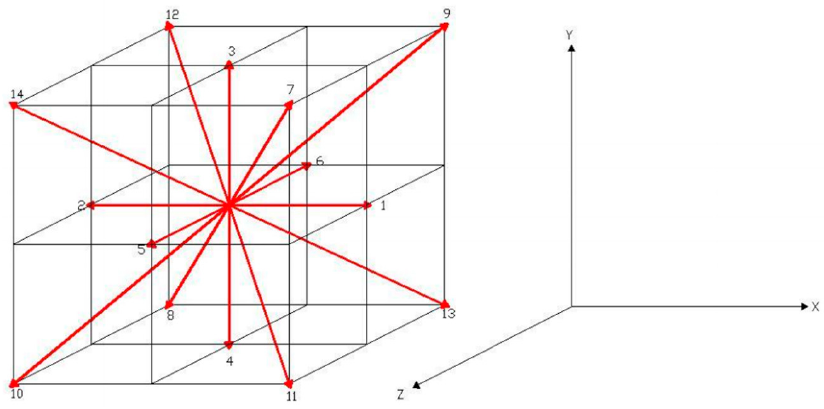
Figure 1. Schematic illustration of space discrete and velocity discrete in the D3Q15 model.